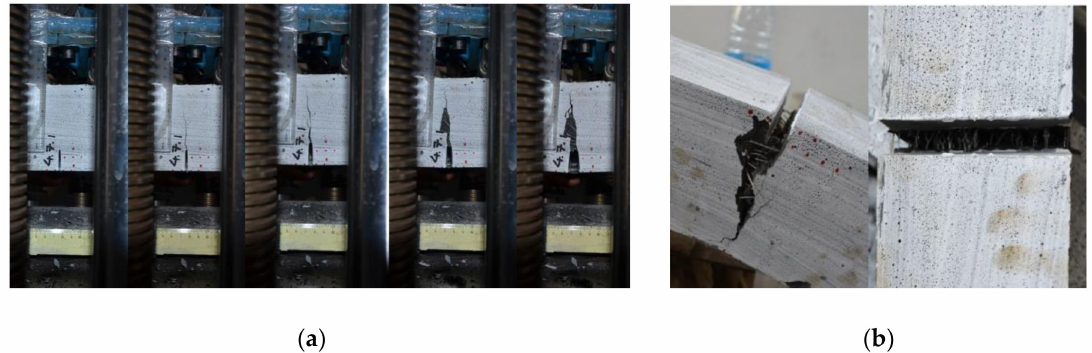
Figure 3. Bending tests on HPFRC beams: ( a ) Crack opening measured on a notched beam with a 4% volumetric fraction of polymer fibers, and ( b ) fibers crack bridge effect.